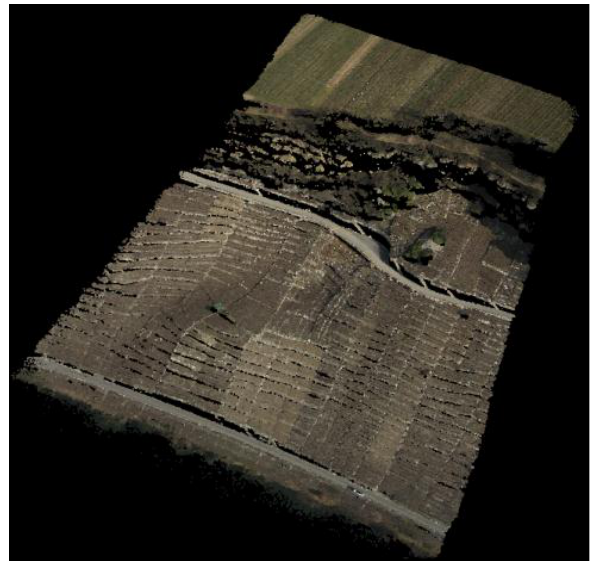
Figure 9: Point cloud generated for single match